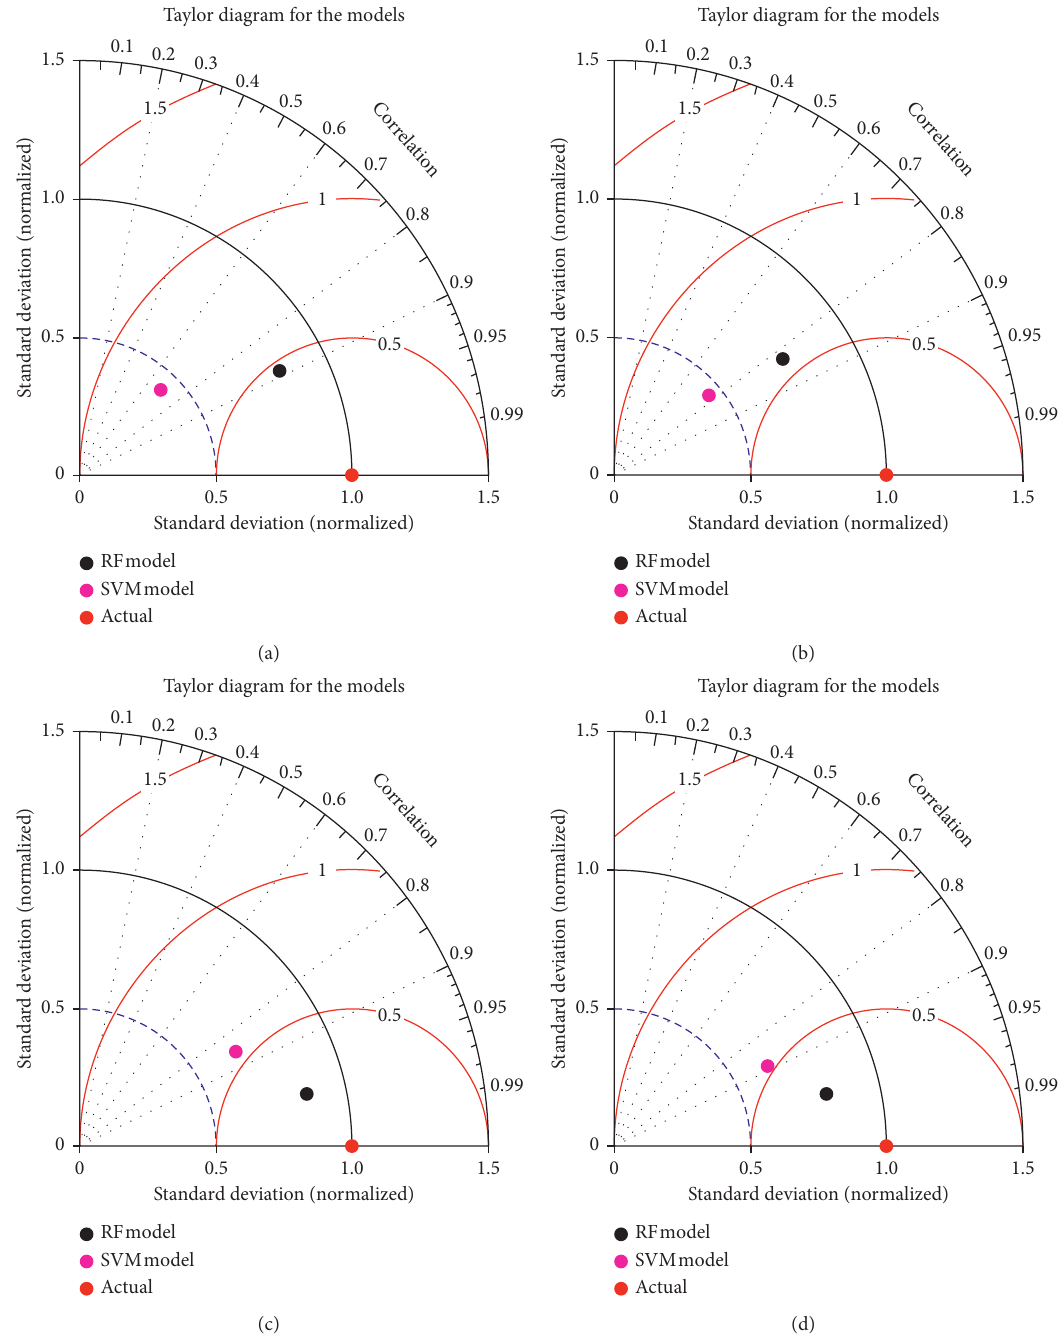
Figure 4: Taylor diagram presentation for the applied and comparable predictive models (RF and SVM). (a) Model 1 training. (b) Model 1 testing. (c) Model 9 training. (d) Model 9